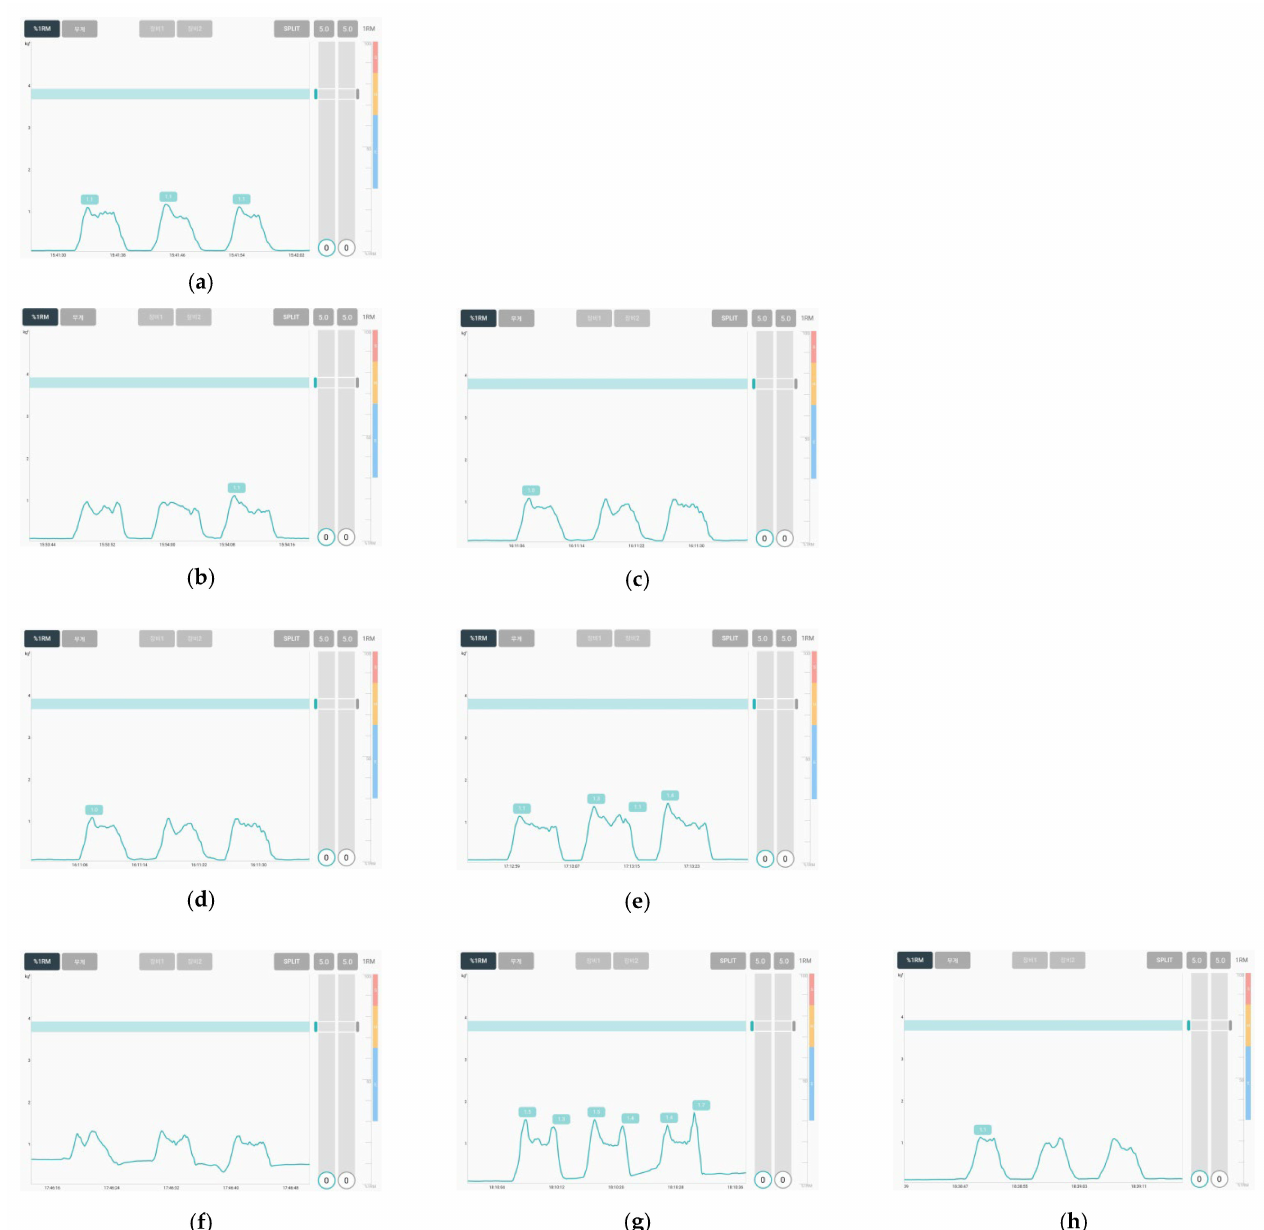
Figure 9. Images of collected sEMG signals by different types of embroidery-based textile electrodes with wearable devices. ( a ) Reference; ( b ) CS_1; ( c ) CS_2; ( d ) Em_LS; ( e ) EM_Ms; ( f ) Kn_PL; ( g ) Kn_PU; ( h )